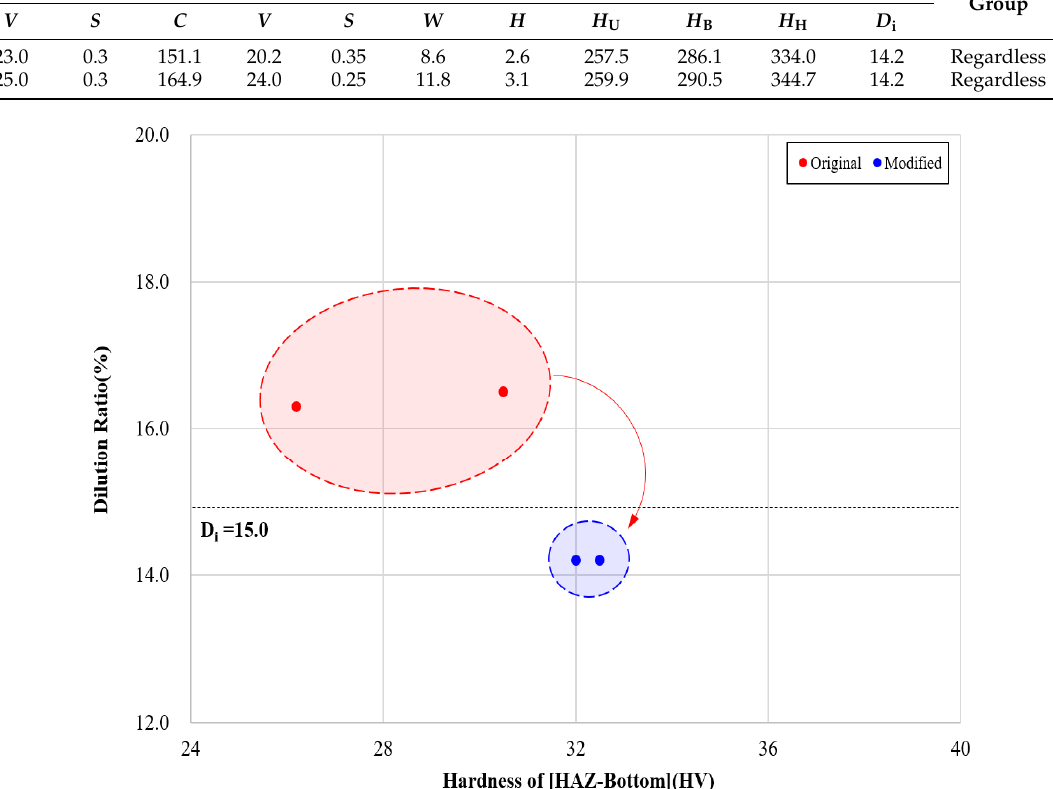
Figure 11. Weldment hardening distributions using modified input parameters.